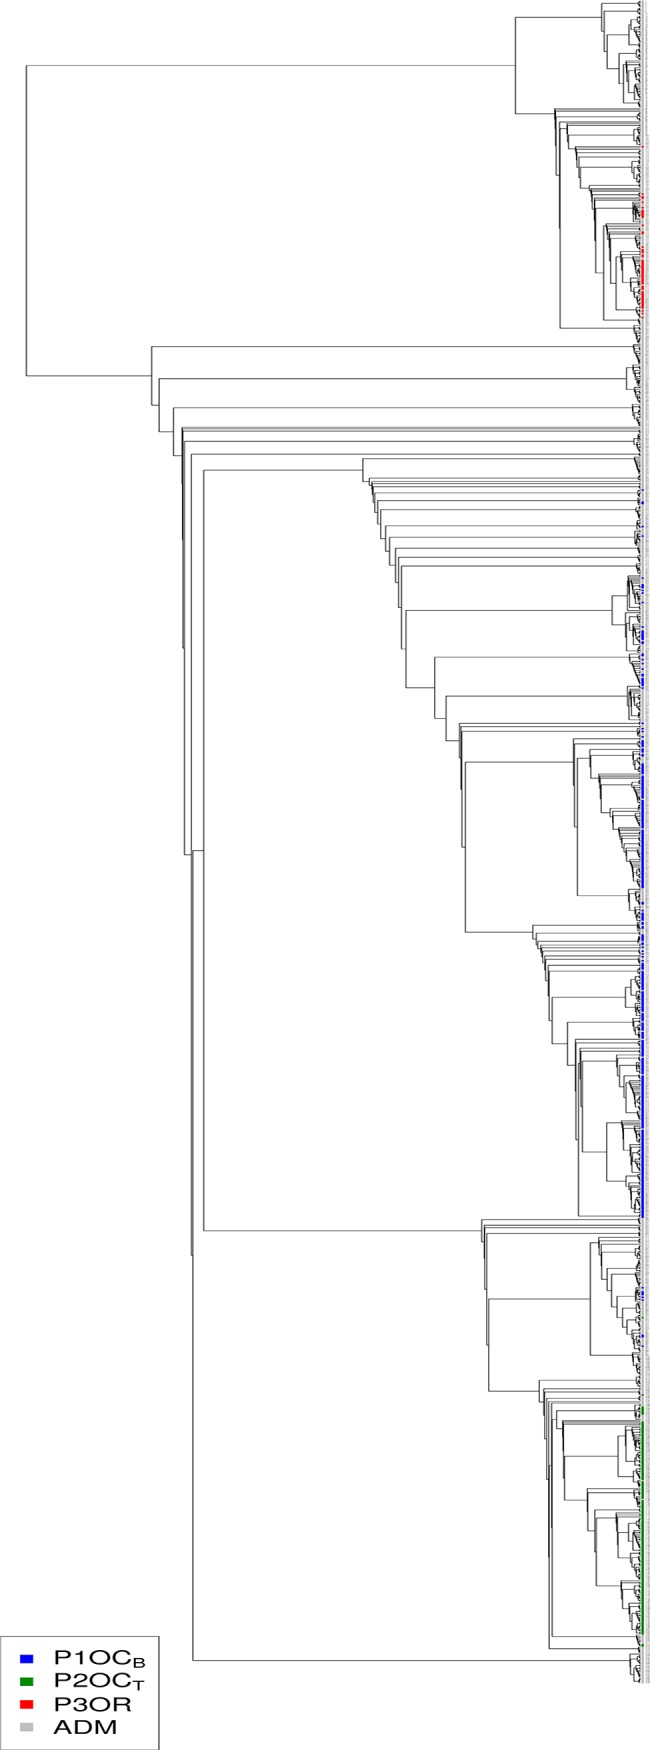
UPGMA tree for the 1,240 accessions.Colors indicate the assignment into populations obtained by STRUCTURE analysis at K = 3. Blue: Occidental/Breeding (P1OCB); Green: Occidental/Traditional (P2OCT); Red: Oriental (P3OR); Gray: Admixture (ADM). Accession names have been replaced by numbers; correspondence between number and accession is provided in S1 Table.